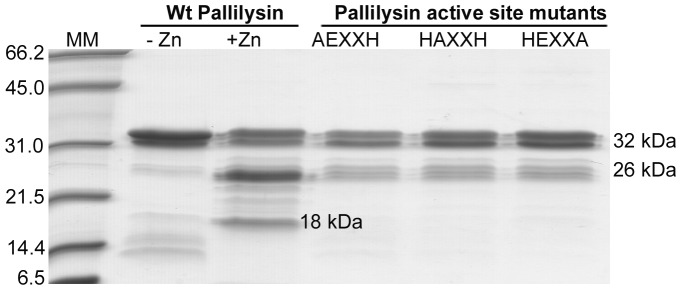
Purification with zinc affects the migration of recombinant pallilysin.SDS-PAGE analysis of purified recombinant wild-type His-tagged pallilysin (C24-P237) purified in the absence (-Zn) and presence (+Zn) of zinc and pallilysin (C24-P237) active site mutants (AEXXH [H198A], HAXXH [E199A], HEXXA [H202A]) purified in the presence of Zn. Each lane contains approximately 6 µg of protein. Numbers to the left of the lanes indicate the size (kDa) of the corresponding molecular mass (MM) markers.